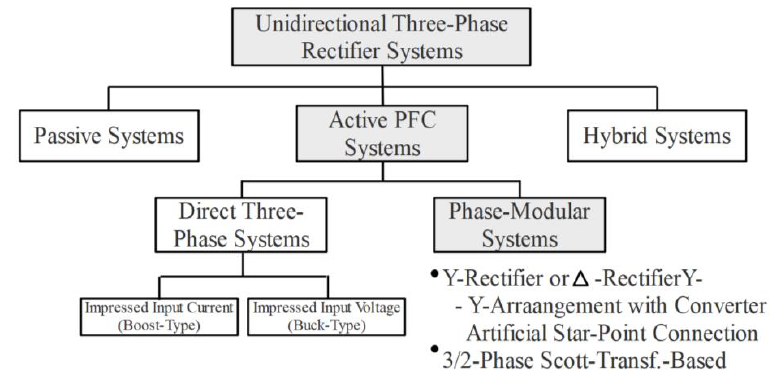
Figure 1. Three-phase hybrid rectifiers types [7,8].